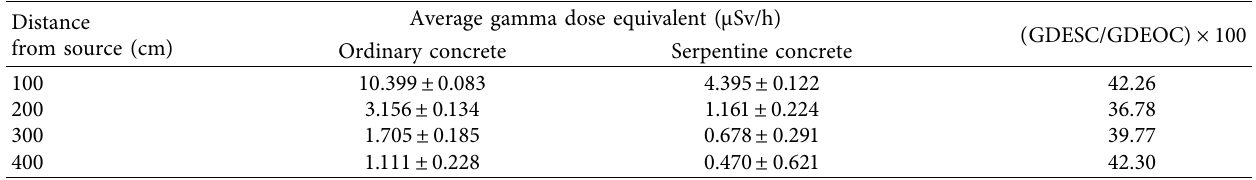
Table 3: Ratio of average gamma dose equivalent of serpentine concrete to ordinary concrete. Distance from source (cm)